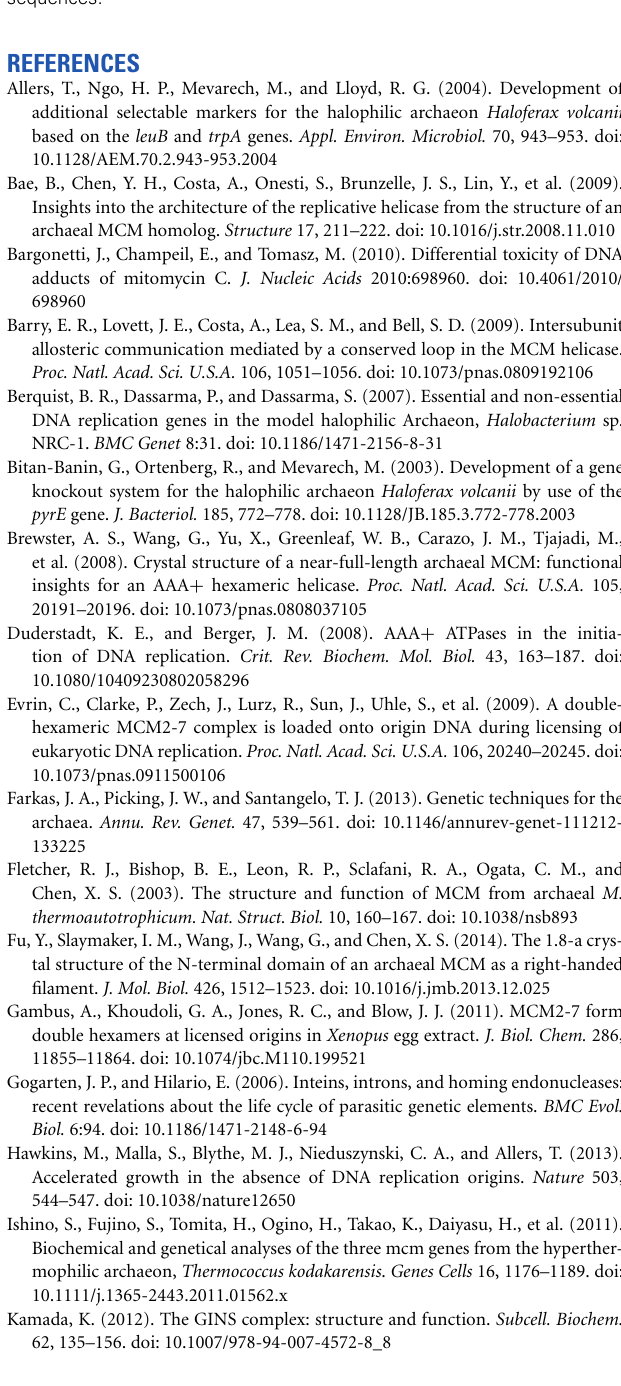
Supplementary Figure S1 | Sequence analysis of β 7- β 8 β -hairpin mutant strains. Codons mutated to encode alanine are boxed. Supplementary Figure S2 | Sequence analysis of β 9- β 10 β -hairpin mutant strains. Codons mutated to encode alanine pairs (mutants bH1–6) are boxed. Vertical lines in hD1 and hD2 indicate location of deleted